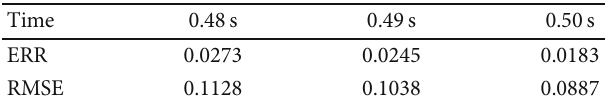
Figure 11: Reconstructed angle and angular velocity of the equivalent model. Table 3: Angle fi tting